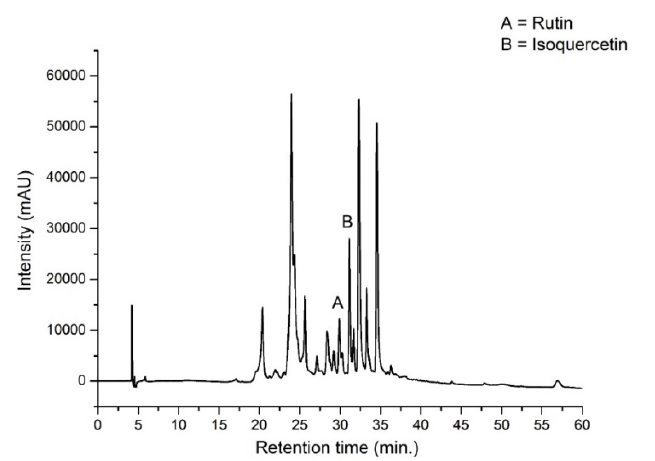
Figure 2. Typical chromatographic profile of the crude hydroalcoholic extract of Morus nigra obtained by HPLC–DAD at a wavelength of 340 nm. Chromatographic conditions are described in Section 2.2.